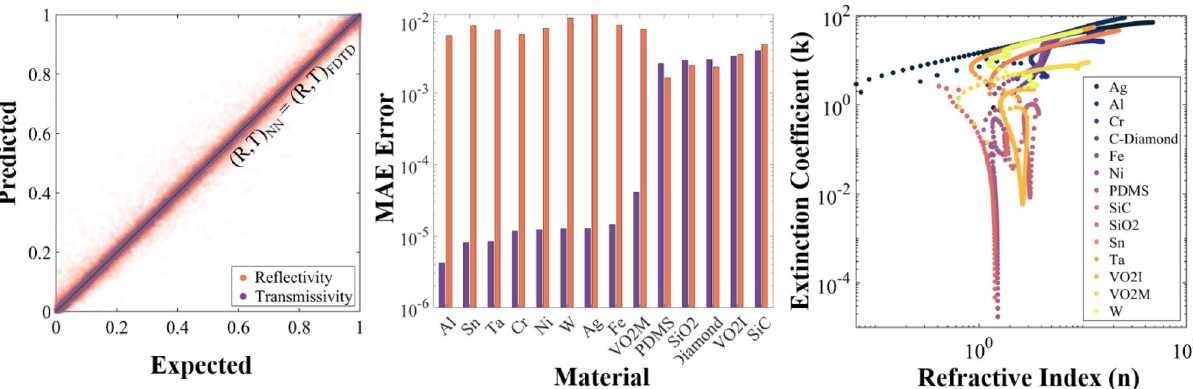
Figure 2. ( a ) neural network predictions of the optical properties compared to the properties obtained from FDTD simulations plotted for the test dataset. ( b ) By material average mean absolute error (MAE) for reflectivity (orange) and transmissivity (blue) separately for the test dataset. No error exceeds 0.01, the overall test dataset has an MAE of 0.0034. ( c ) The extinction coefficient (k) vs the refractive index (n) for all of the materials included in the test dataset, highlighting the differences between the materials used in the training of the